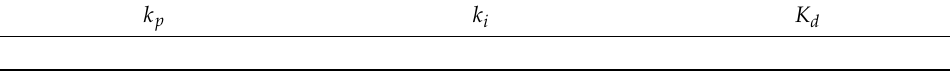
Algorithm A2: Pseudo-code of